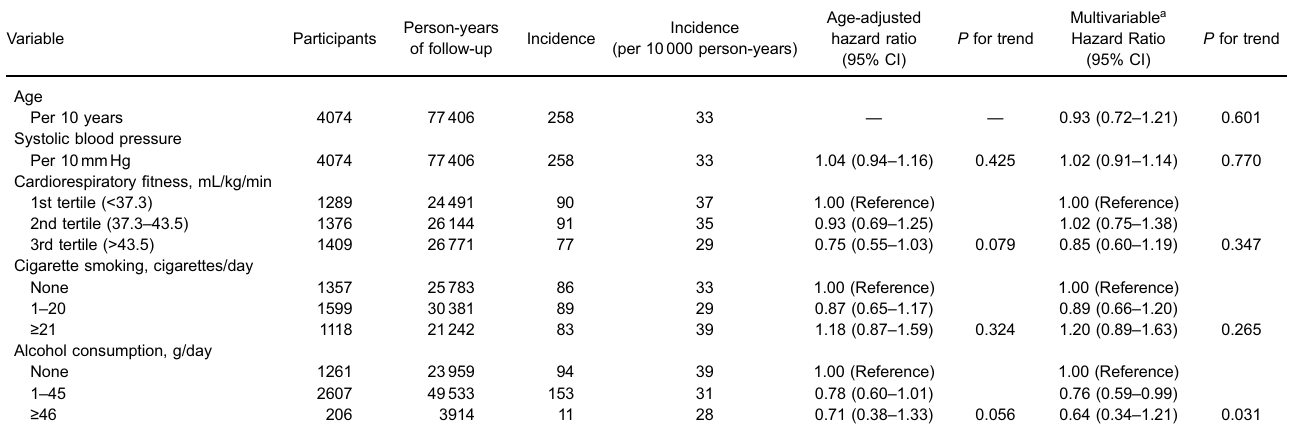
Table 2. Hazard ratios for incidence of kidney stones by potential confounders, 1985 to 2004 – 05